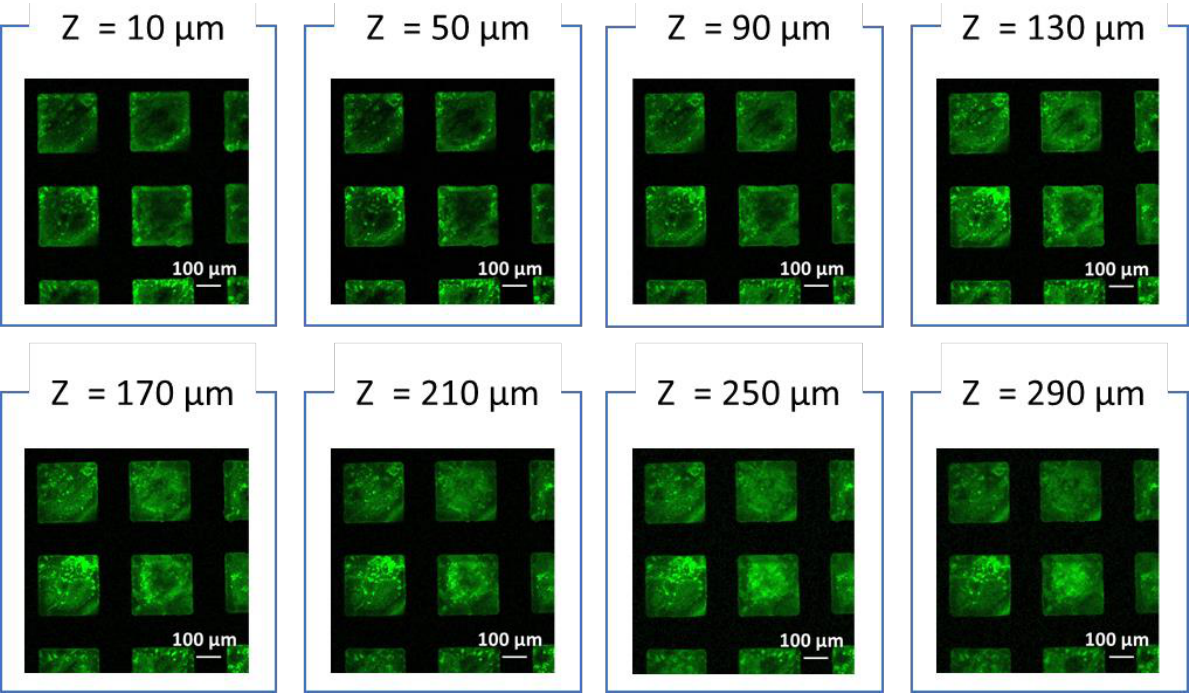
Figure 6. An analysis of the reactivity of the fabricated porous maleimide-functionalized poly -p- xylylenes. The fluorescence images recorded by confocal laser scanning microscopy (CLSM) showed consistent 300 μm × 300 μm arrayed patterns that confirmed the conjugation between the fluorescein (FITC)-labeled cysteine and the maleimide group on the porous materials, and the images at various Z-axes (with a 40 μm spacing interval from 10 μm to 290 μm) further verified the reactivity on the interface of the porous materials in three dimensions.